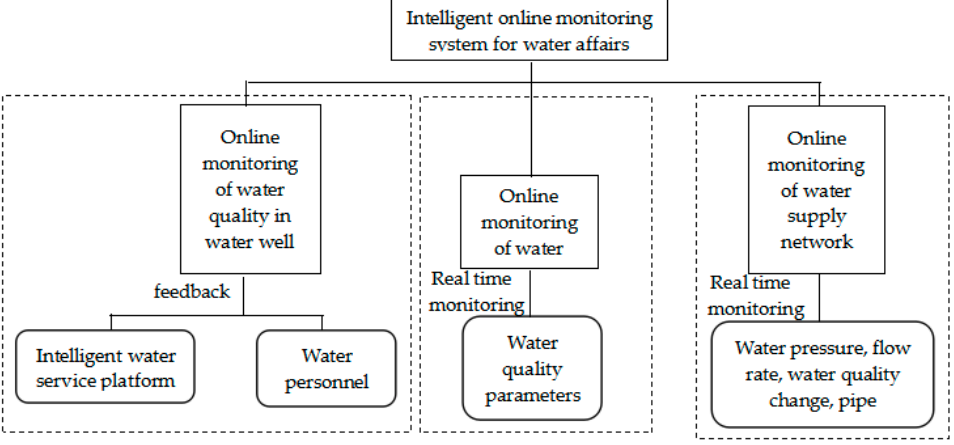
Figure 2. Flow chart of online monitoring system for intelligent water